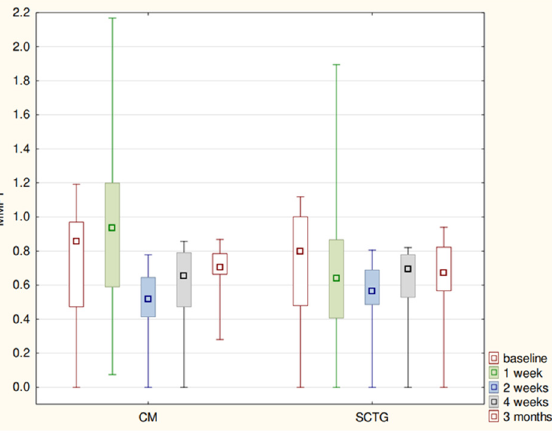
Figure 1. MMP1 levels (median-quartiles-range) at relevant stages of study.